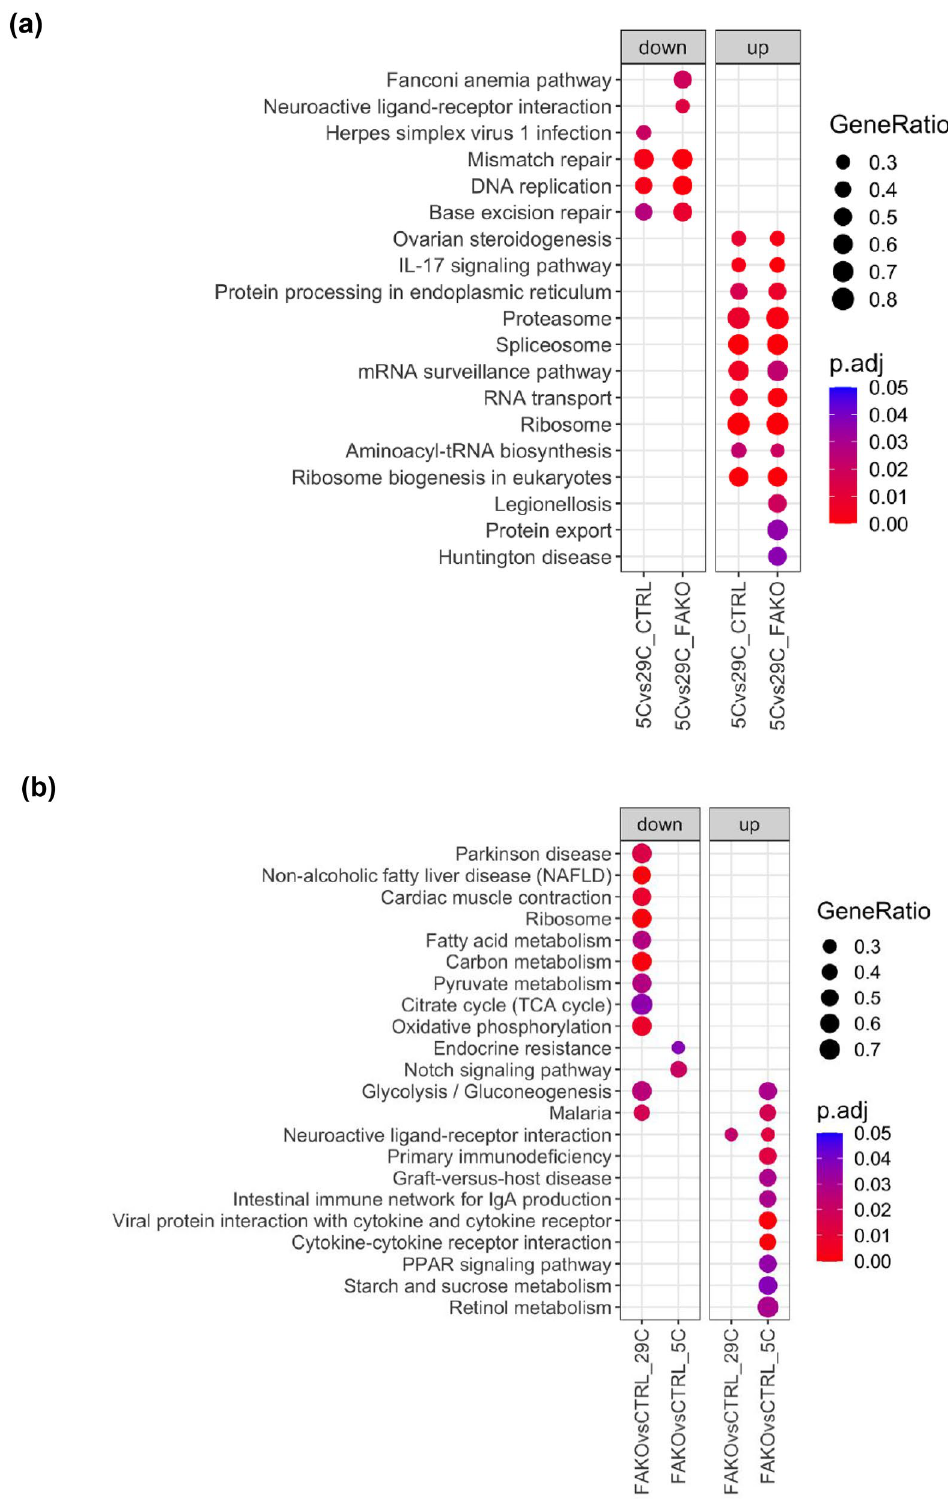
Figure 4. Afadin deletion leads to transcriptomic alterations in BAT at thermoneutrality and in response to cold. Male fat-specific Afadin knock-out (FAKO) and control littermates (CTRL) were housed at thermoneutrality (29 °C) for 2 weeks followed by 5 °C cold-exposure for 6 h and BAT was harvested and RNA- sequencing was performed. ( a , b ) Gene set enrichment analysis (GSEA) for each comparison. Top 10 significant up/down regulated KEGG terms containing at least 10 genes were plotted using gene ratio, regulated by temperature ( a ) and in between genotypes ( b ). Full list of enriched KEGG terms can be found in